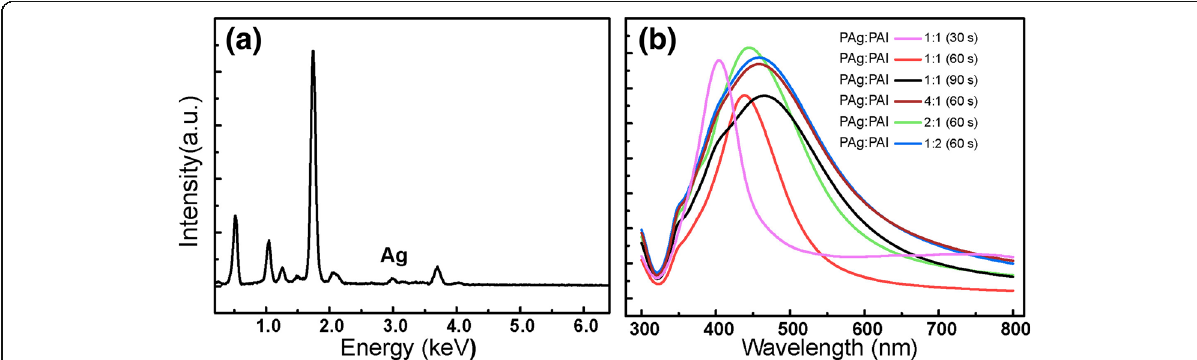
Fig. 4 a EDS characterization of the sample prepared by co-sputtering (Ag, Al) targets for 60 s at 1:1 power rate. b UV-visible absorption spectrum of Ag NPs prepared with different co-sputtering time and power